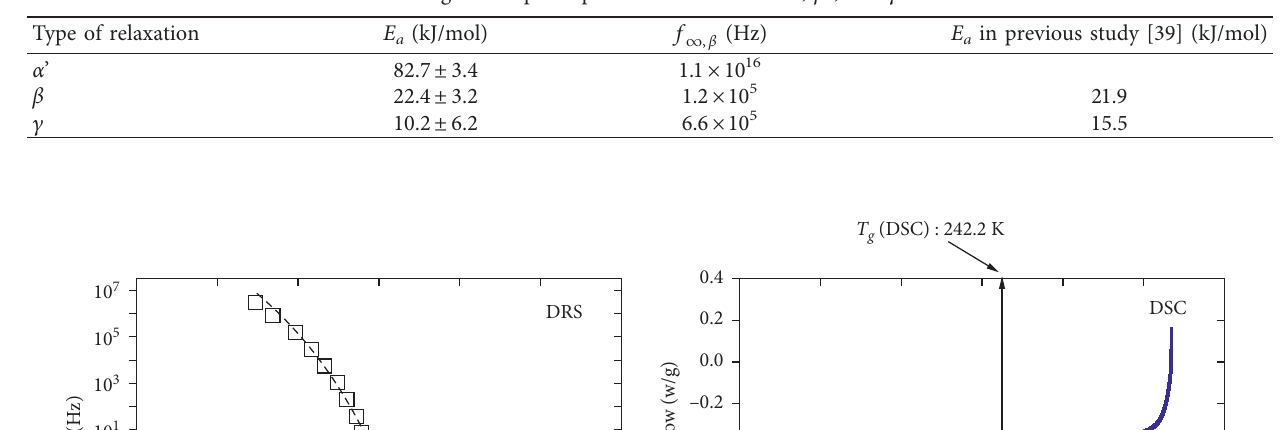
Table 4: Activation energies and pre-exponential factors for α ’-, β -, and c -relaxations in NBR.